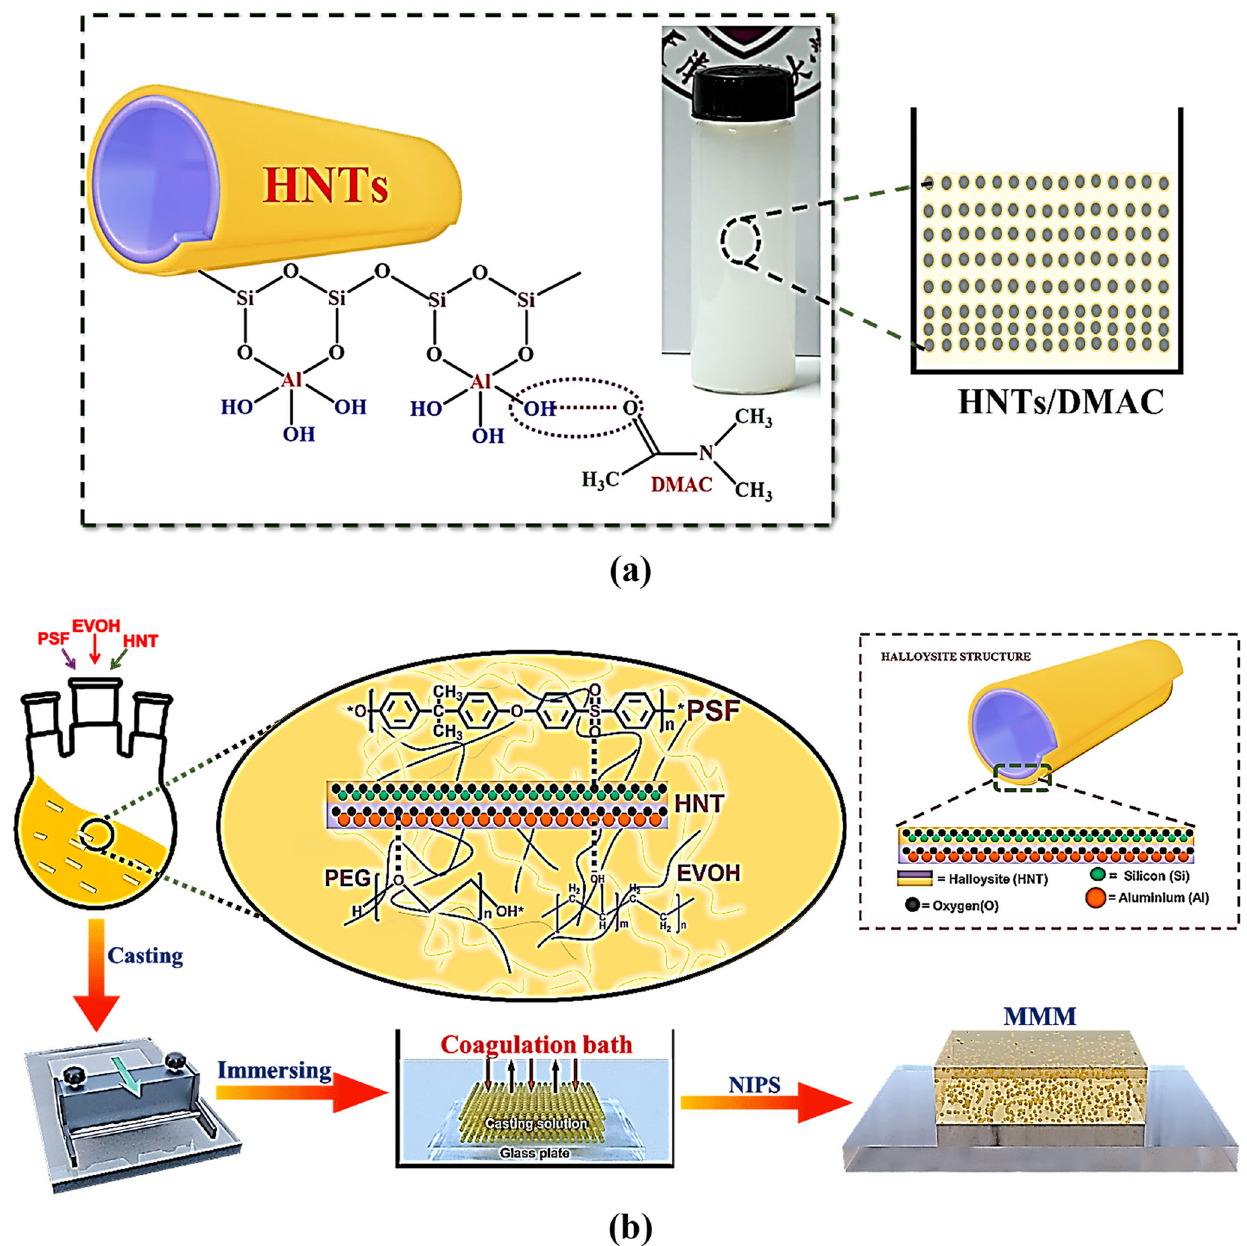
Fig. 10 Proposed interactions between PSF, EVOH, PEG, DMAc and HNTs and Formation of asymmetric MMM. a Proposed interactions between HNTS and DMAc solvent, b Depiction of the process of membrane synthesis, proposed interactions amongst PSF, EVOH, and